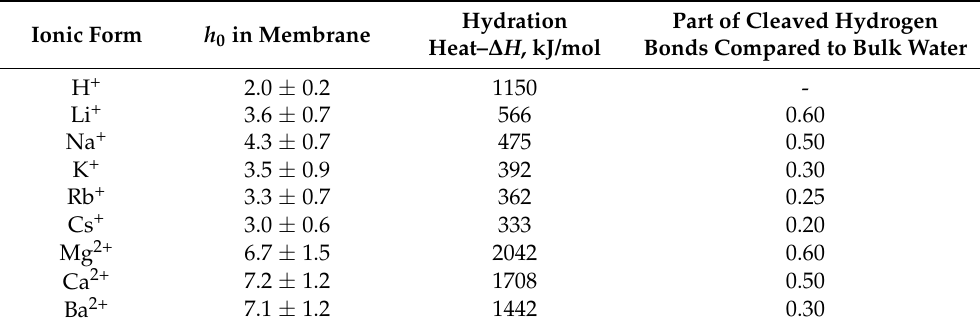
Table 4. Hydration numbers h 0 , hydration heat, and a part of cleaved hydrogen bonds in the MF-4SC membrane (adapted from [36]).